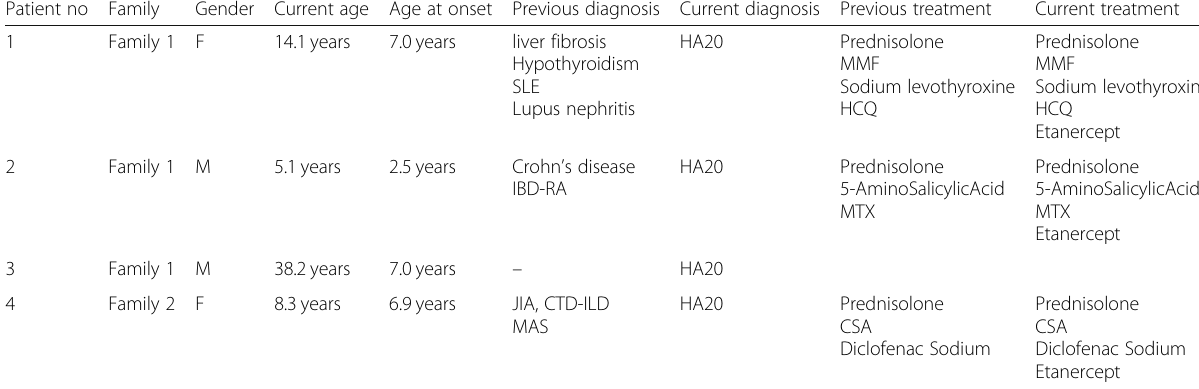
Table 1 Characteristics of patients with HA20 Patient no